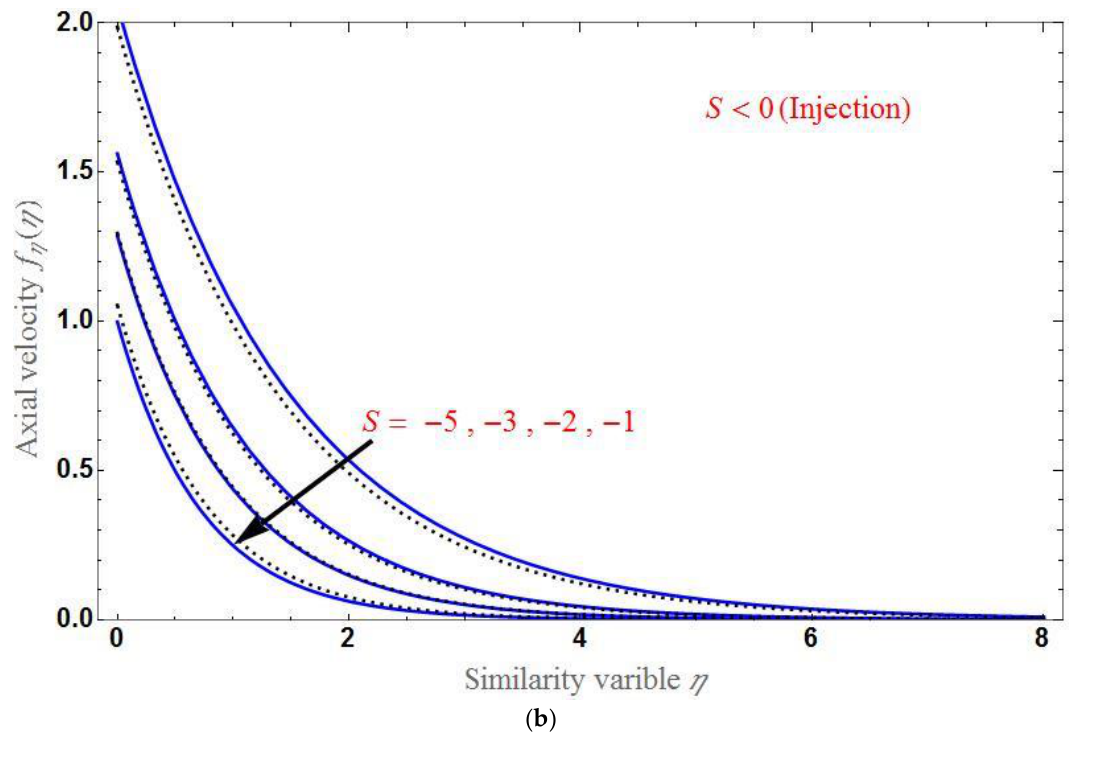
Figure 5. The axial velocity as a function of η for various values of S , ( a ) for suction case and ( b ) for injection case. The other fixed parameters are: Λ = Da − 1 = M = 1, φ 1 = 0.1, φ 2 =